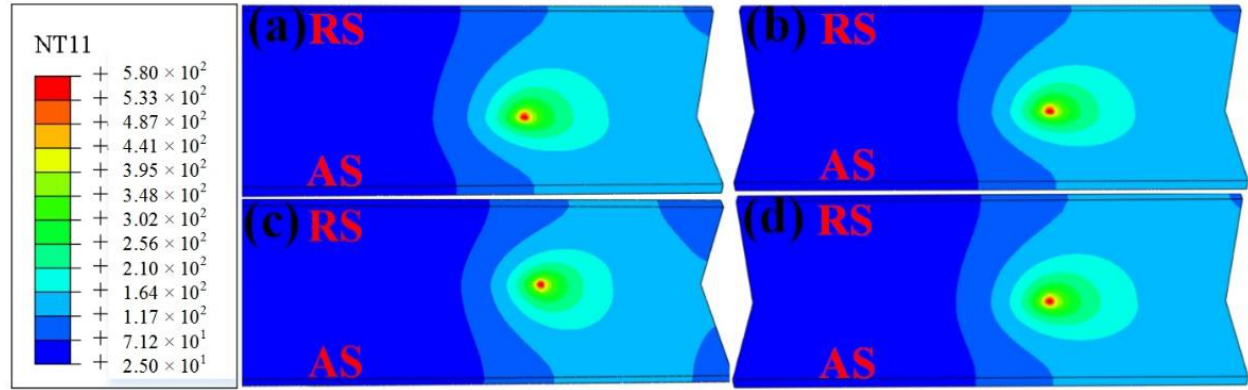
Figure 5. Comparison between the simulated thermal cycle curves and the measured results under typical welding parameters.